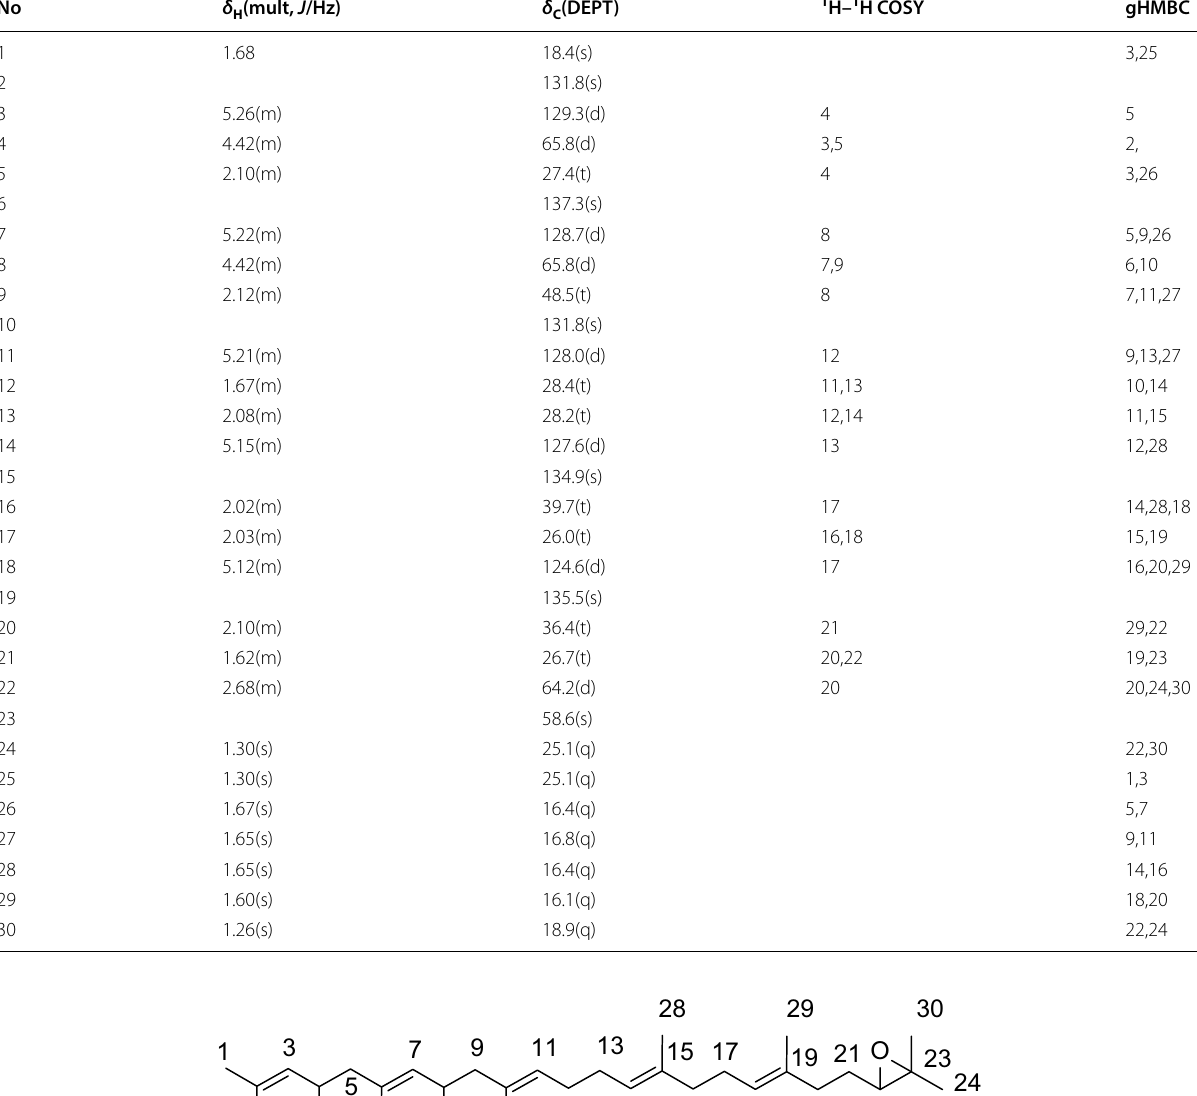
Table 1 NMR data of